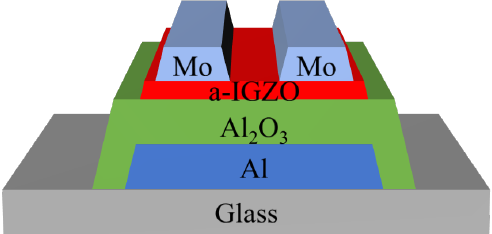
Figure 1. Schematic of the amorphous Indium-Gallium-Zinc Oxide (a-IGZO) thin-film transistors